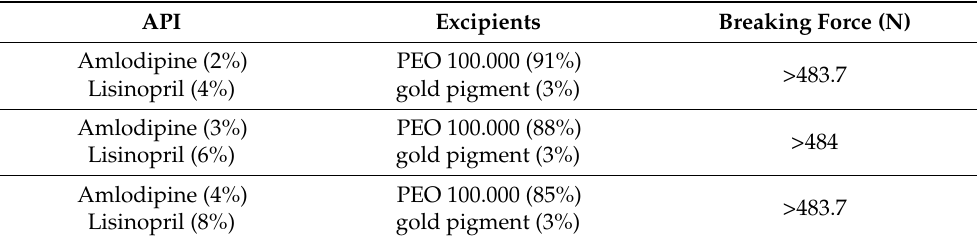
Table 6. The mechanical properties of SLS printed tablets with different concentrations of two separate active pharmaceutical ingredients